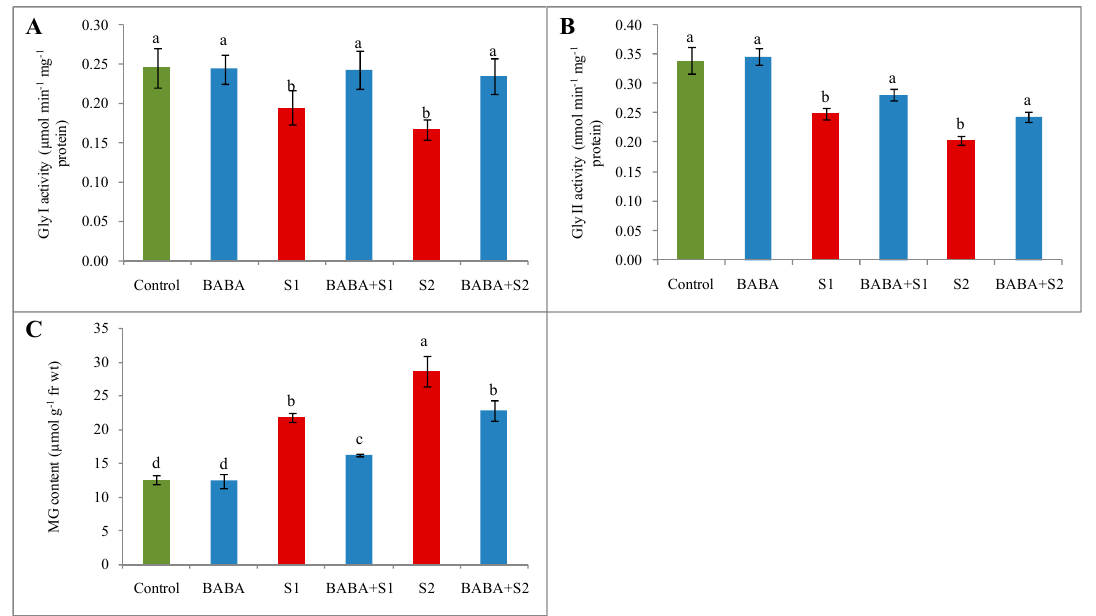
Figure 6. Effect of BABA on Gly I activity ( A ), Gly II activity ( B ) and MG content ( C ) of rapeseed ( Brassica napus L.) seedlings exposed to different concentrations of salt stress. Average from three replications (n = 3) was used to determine mean ( ± SD) for each treatment. Letters with different values varied significantly at p ≤ 0.05 according to Fisher’s LSD test. Here, BABA, S1 and S2 indicate 150 μ M β -aminobutyric acid, 100 mM NaCl and 150 mM NaCl, respectively.